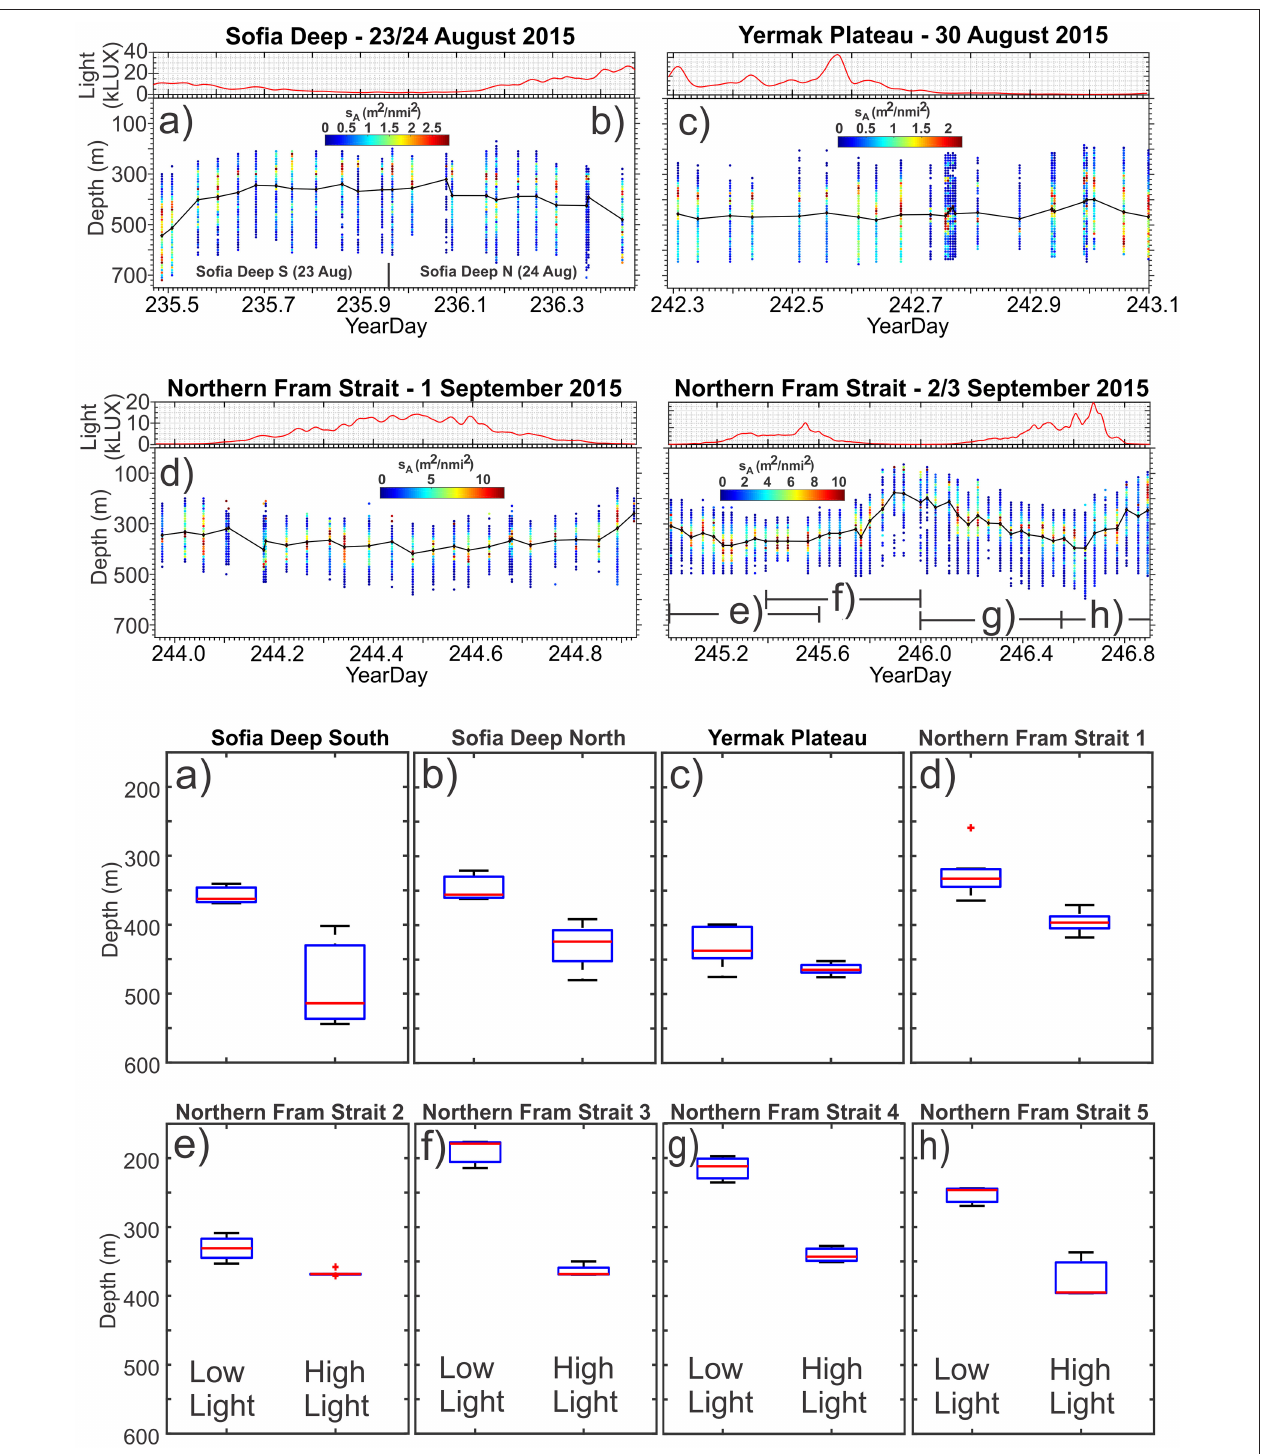
FIGURE 3 | Light levels and vertical distribution of scrutinized acoustic DSL NASC data assessed as originating from backscattering from mesopelagic organisms (two upper panels), and box plots of the depths of the high-light and low-light depths of weighted mean value of scrutinized DSL backscattering at 38 k3Hz (two lower panels). Panels (a–h) denote the eight locations visited (see text for